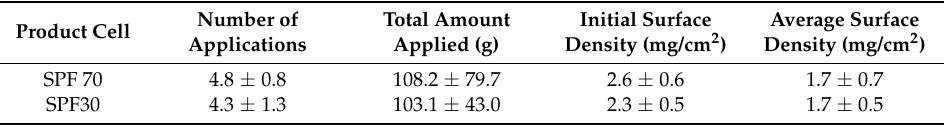
Table 2. Application amount and surface density (mean ± standard